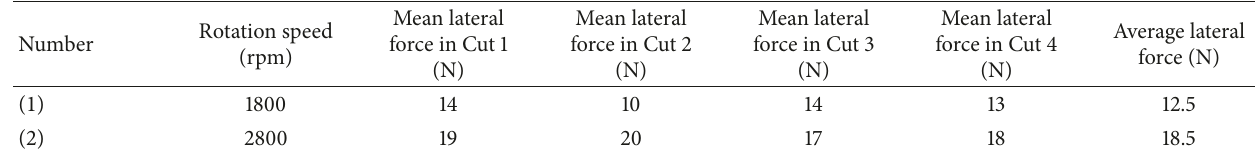
Table 4: Mean value of measured lateral